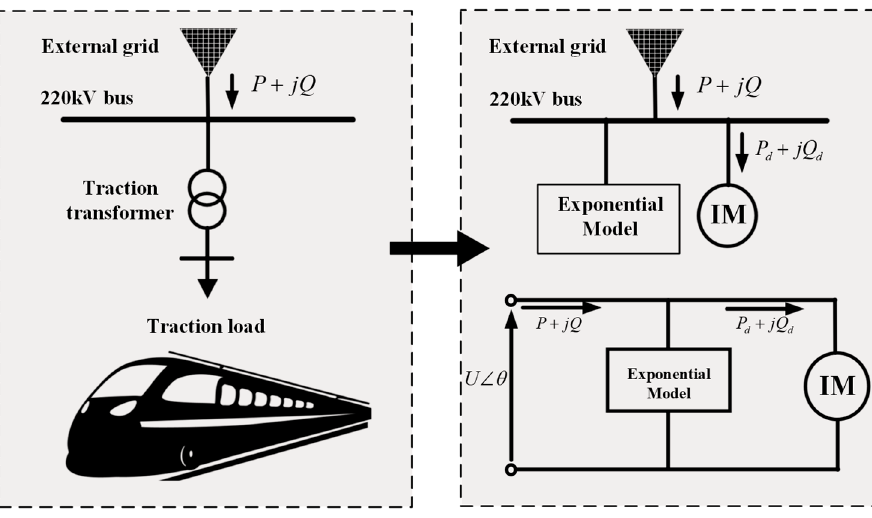
Figure 1. Traction composite load equivalence model.